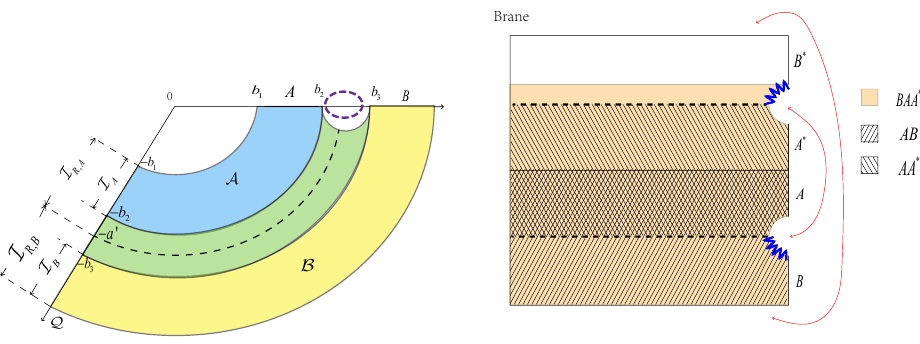
Figure 8 . Phase-D4. In this phase, the entanglement islands for A and B are different from their reflected island. One boundary of EWCS and one gap between A ∪ I R,A and B ∪ I R,B give the lower bound h ≥ c log 2 . There is one jagged surface, with W( AA ∗ B ) ⊃ W( AA ∗ ) ∪ W( AB ) 3